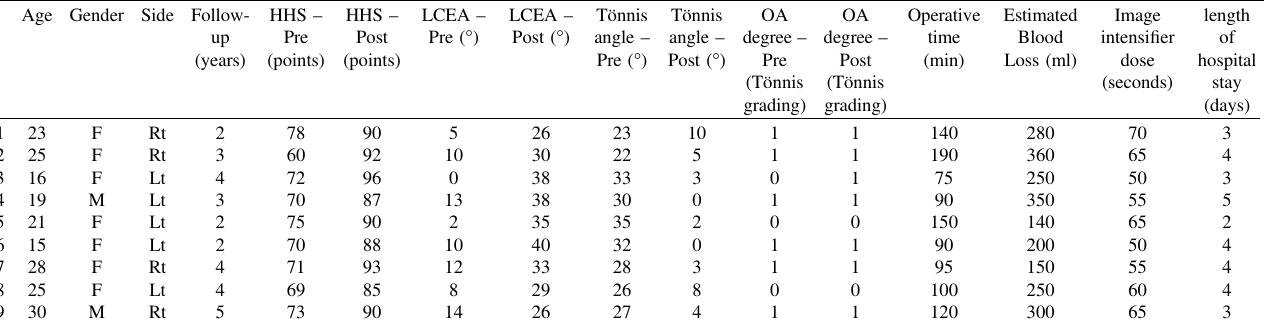
Table 1. Patients ’ demographic, clinical, and radiographic